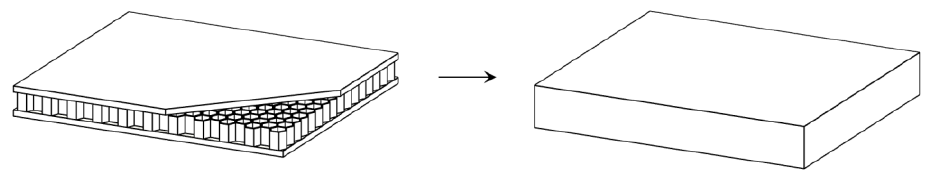
Figure 2. Schematic diagram of the equivalent transformation.